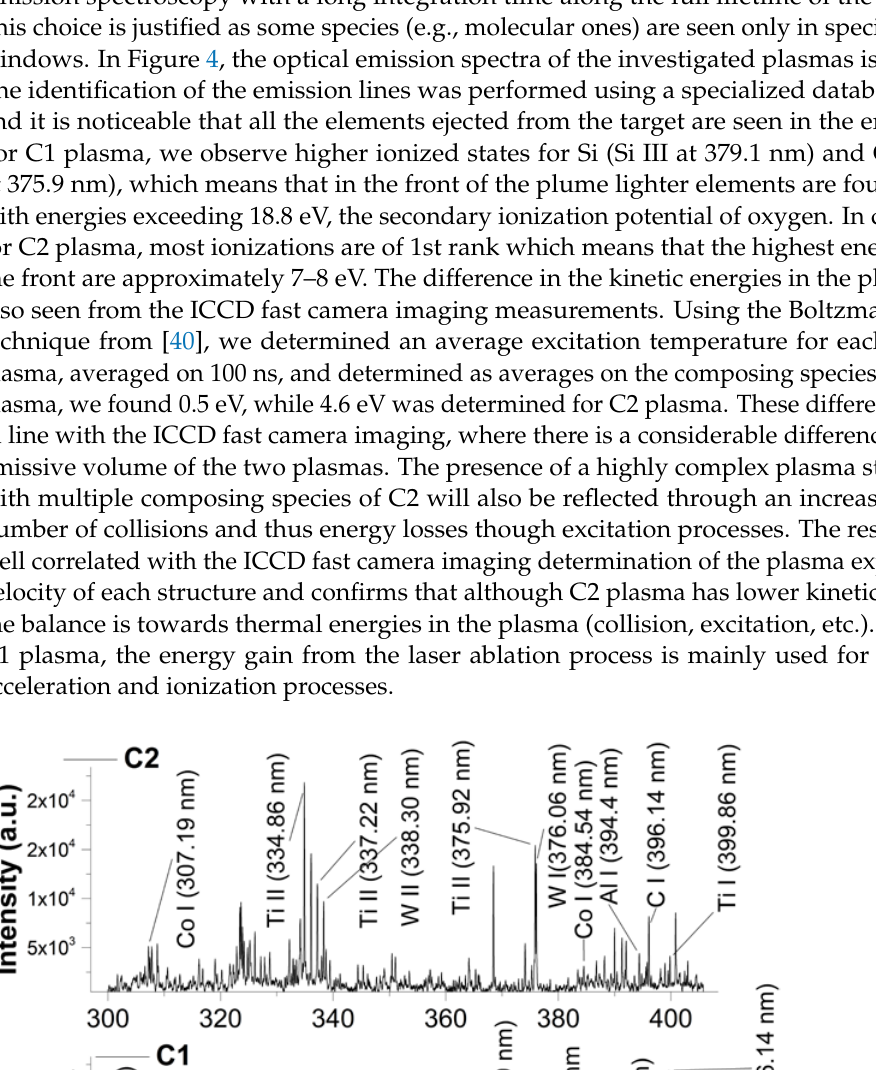
were recorded at various moments in time according to the procedure reported in [41]. In Figure 5, the spatial distribution of the electron excitation temperatures of the two inves- tigated plasmas are shown. The excitation temperatures determined for the plasma gen- erated in C2 are higher than those for the plasma generated in C1 by approximately a factor of 2. It can also be seen that the evolution depicts a first maxima at 2.1 mm from the target for C2 (4.6 eV) and at 3 mm for C1 (2 eV), followed by a second one at 3.7 mm for C2 (2.5 eV) and another at 4.5 for the plasma generated on C1 (0.3 eV). The multiple max-